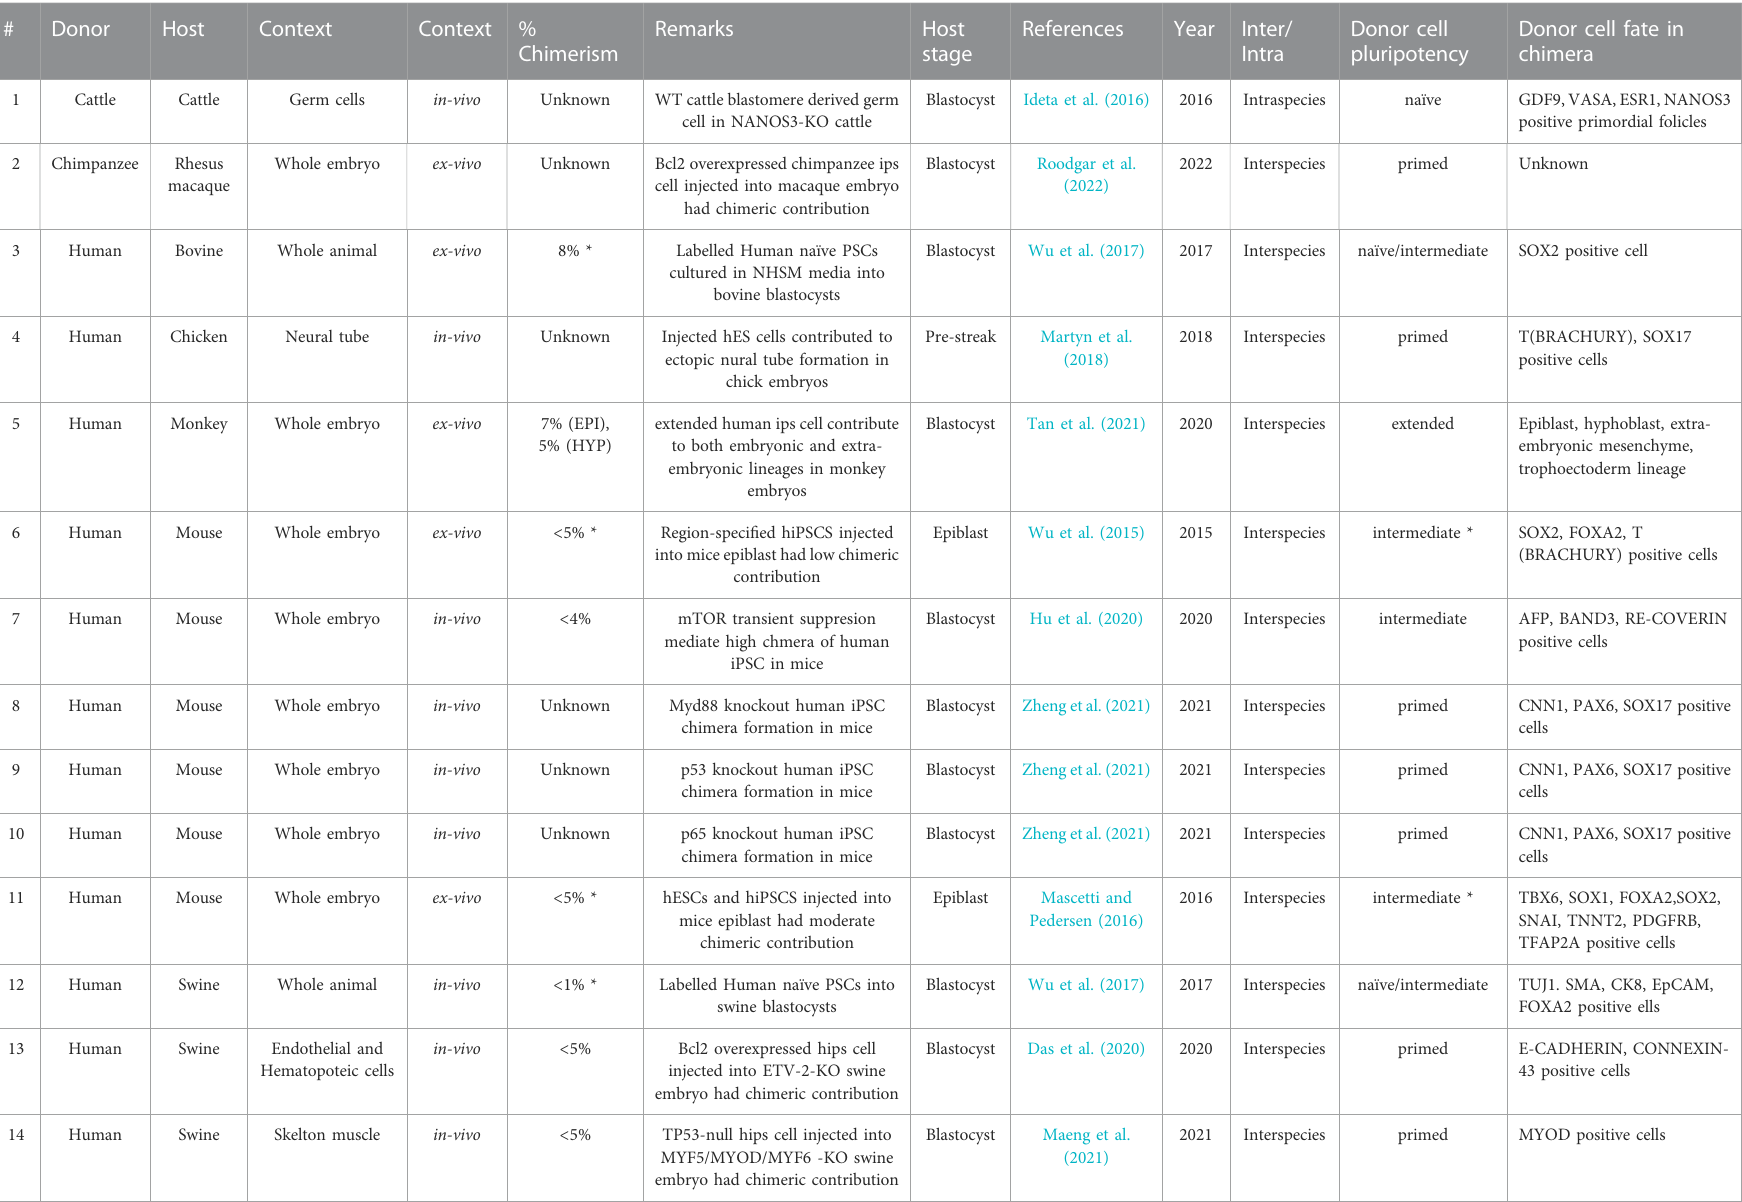
TABLE 1 Chimerism between various donor and host-derived